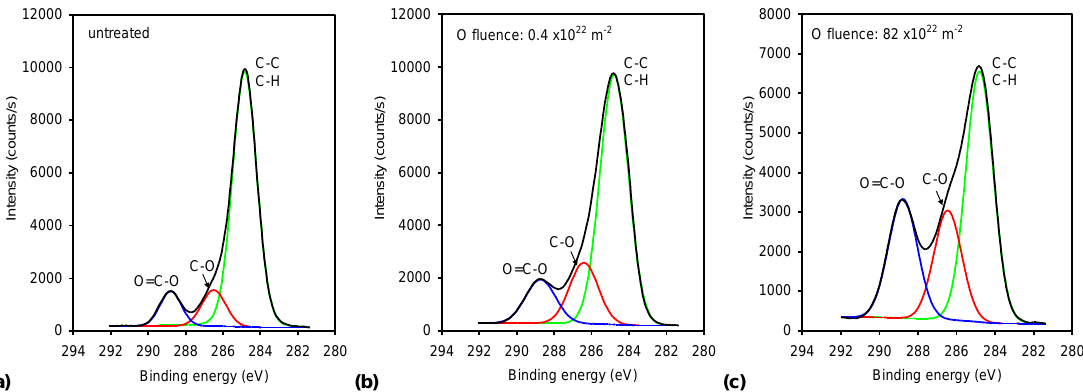
Figure 6. An example of fitting of XPS spectra: ( a ) untreated sample; ( b ) sample treated with a low O-atom fluence; and ( c ) sample treated with a high O-atom fluence.